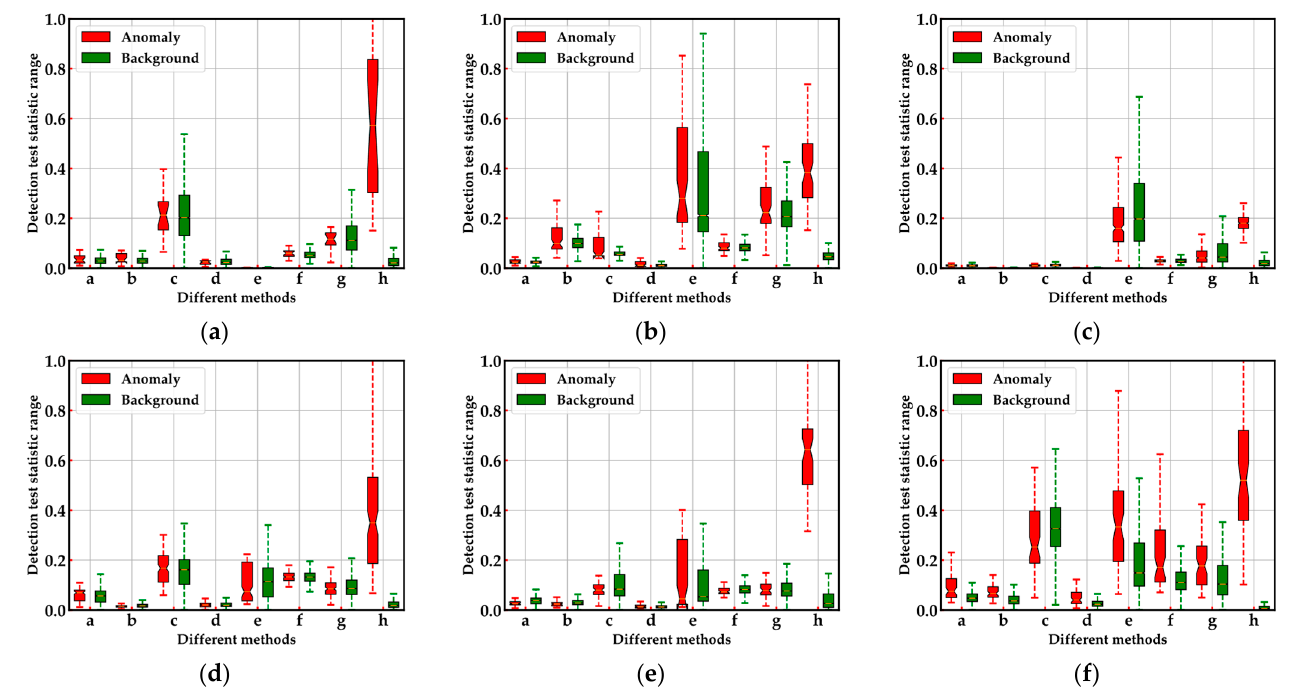
Figure 14. Anomaly–background separability maps of different methods on ( a ) HYDICE, ( b ) Pavia, ( c ) Los Angeles, ( d ) San Diego-I, ( e ) San Diego-II and ( f ) Texas Coast. Here, letters “a–h” stand for RX, CRD, LRASR, LSMAD, PAB-DC, LSDM–MoG, KIFD and proposed method,